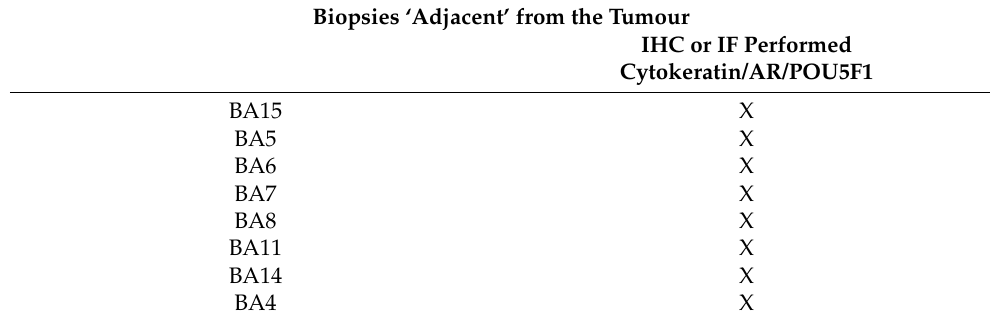
Table A7. Immunohistochemistry and Immunofluorescence performed on biopsies obtained in areas ‘adjacent’ to the seminoma